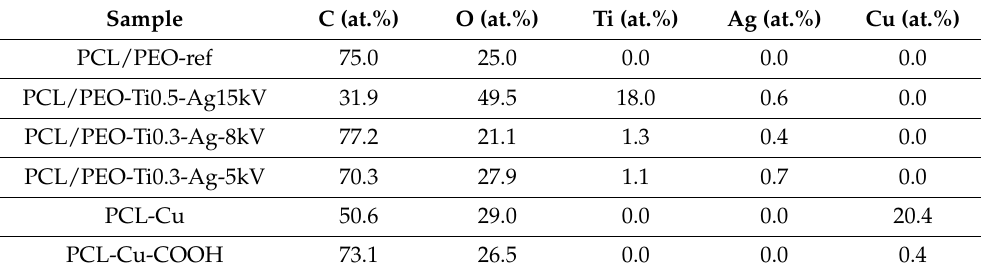
Table 1. Composition of the samples (in at.%) derived from XPS analysis.